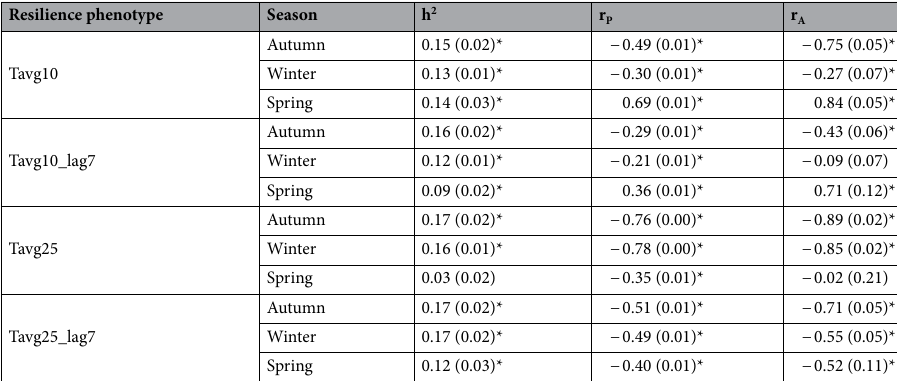
Table 3. Heritability estimates of seasonal animal resilience phenotypes and correlation with lifetime milk production at different temperature levels (standard errors in parentheses). Tavg10, Tavg25: milk yield change by 1 °C temperature change at 10 °C and 25 °C on the milk test date, respectively; Tavg10_lag7, Tavg25_lag7: milk yield change by 1 °C cumulative average air temperature change during the week preceding the milk test date, h 2 Heritability, r P Phenotypic correlation with corresponding lifetime milk production, r A Genetic correlation with corresponding lifetime milk production. Estimates significantly different from zero (P < 0.01) are indicated with an asterisk.